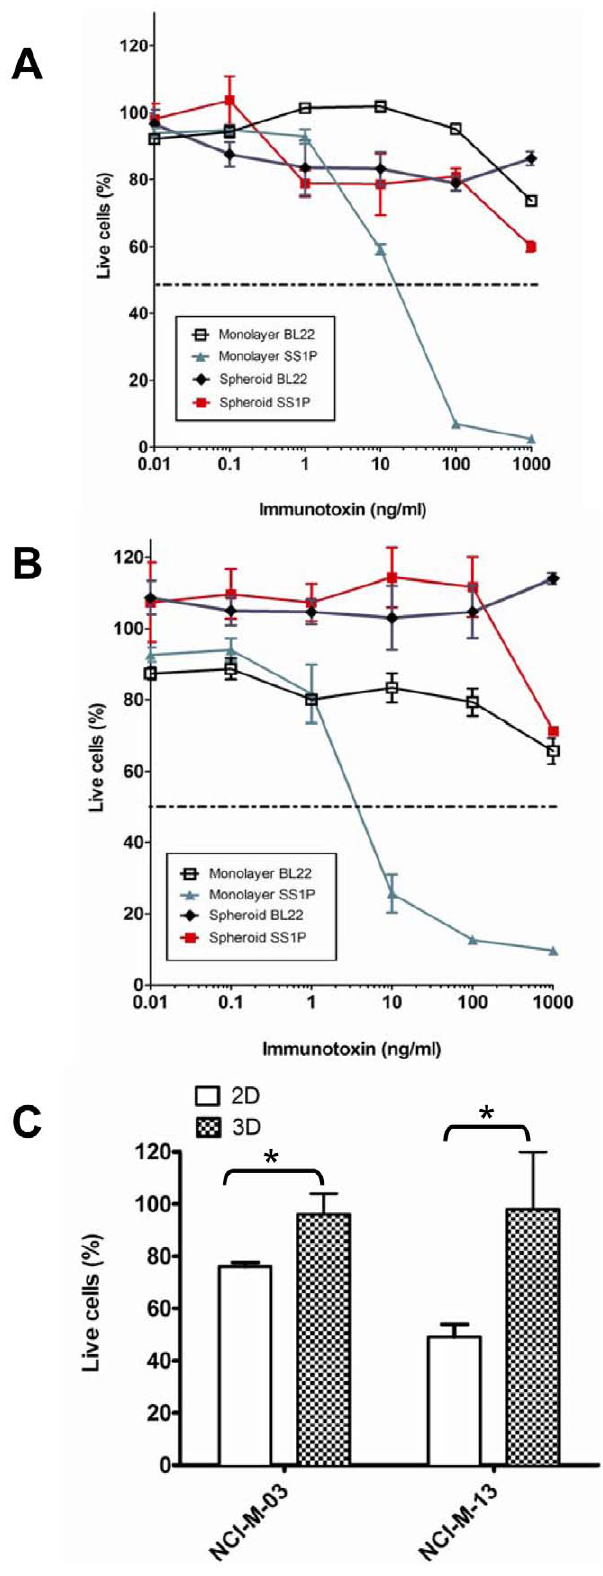
Figure 2. Anti-tumor immunotoxin activity on mesothelioma monolayers and spheroids. Cells treated with SS1P and BL22. A . Cell growth inhibition (WST-8 assays) of NCI-H226. IC 50 of SS1P for spheroids was . 1000 ng/mL. IC 50 for monolayers was , 10 ng/mL. B . Cell